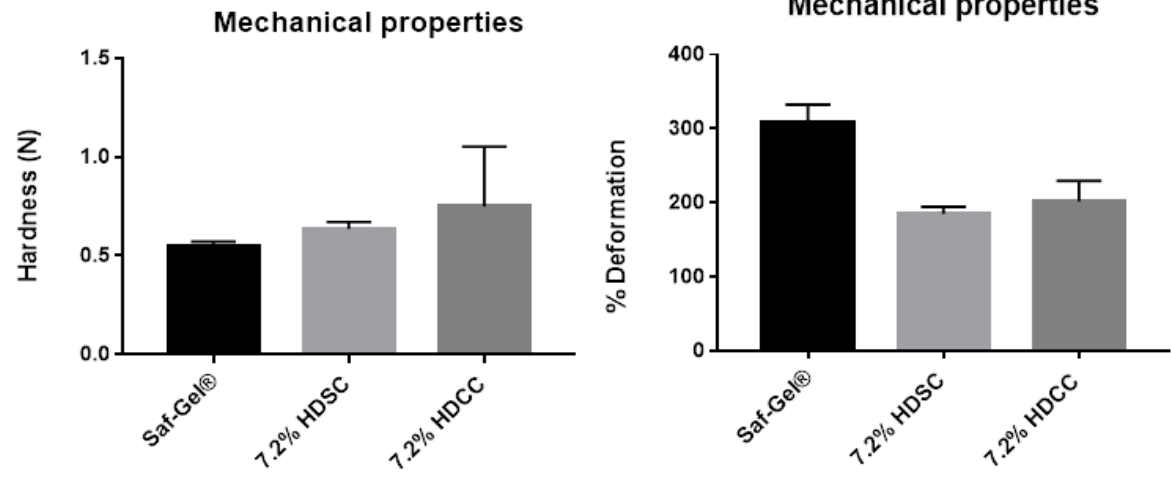
Figure 4. Mechanical test of 7.2% HDSC, 7.2% HDCC and control Sal-Gel ® in texturometer .